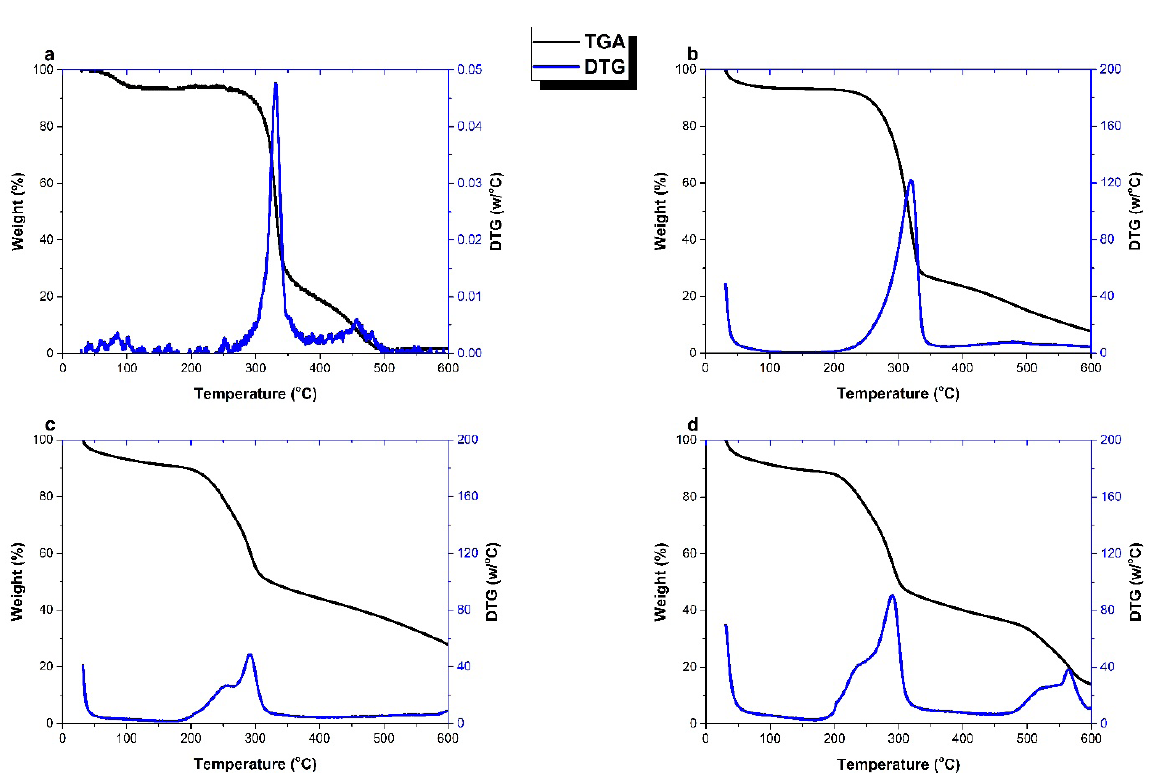
Figure 7: TGA and DTG curves of (a) α-cellulose, (b) CNF1, (c) CNF2 and (d) CNF3.